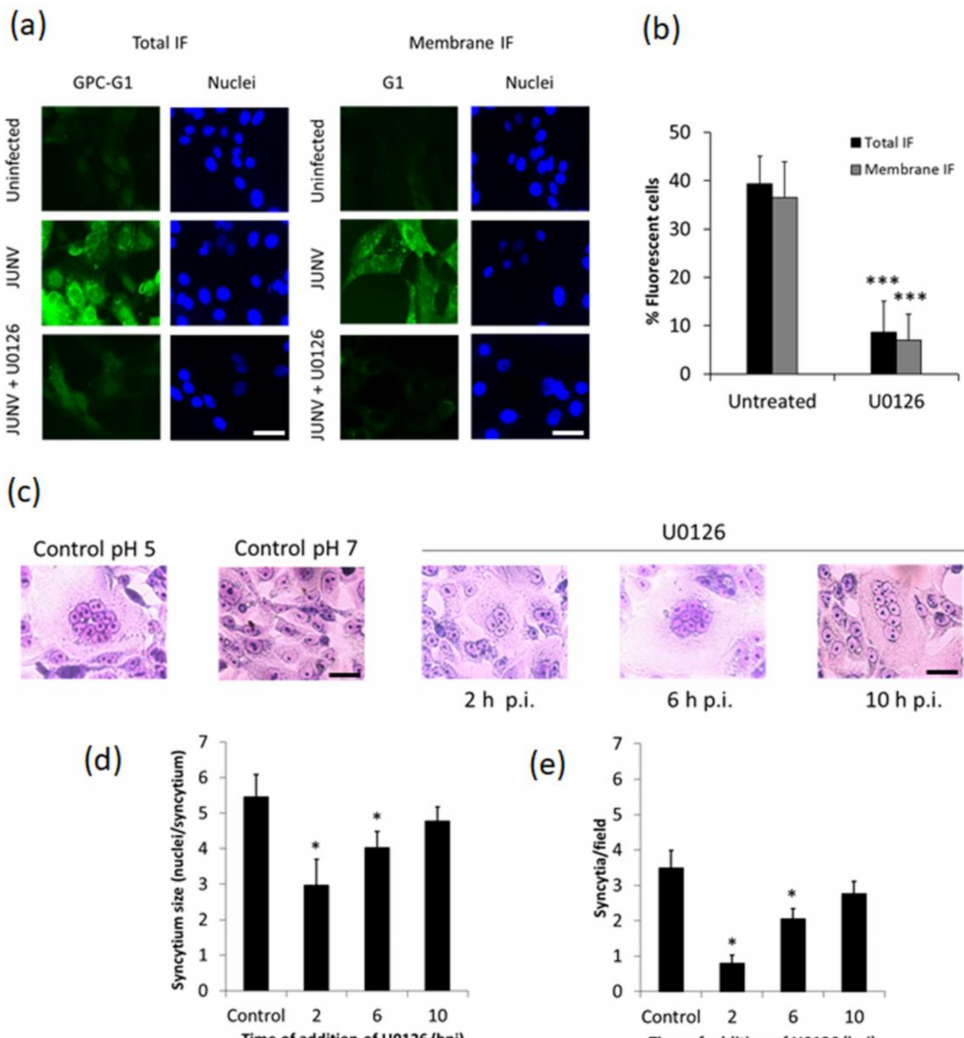
Figure 3. U0126 inhibits viral glycoprotein expression. ( a ) Cells were infected with JUNV (m.o.i. = 1) and U0126 (15 µ M) was added 2 h later. At 24 h p.i. total and membrane G1 expression was analyzed by immunofluorescence (IF) assay. Scale bars: 10 µ m; ( b ) The percentage of fluorescent cells was calculated by counting 20 random selected fields; data represent mean values ± SD. ANOVA (Tukey post-hoc test): *** p < 0.001; ( c ) Vero cells were infected with JUNV (m.o.i. = 1) and U0126 (15 µ M) was added at the indicated time points. At 14 h p.i. cells were treated for 30 min with culture medium at pH 5.0. Ten hours later, cells were fixed, stained with Giemsa and visualized using an optic microscope. Scale bars: 10 µ m; The size ( d ) and number ( e ) of syncytia were calculated by counting 20 random selected fields (400 × magnification); data represent mean values ± SD. ANOVA (Dunnett post-hoc test): * p <